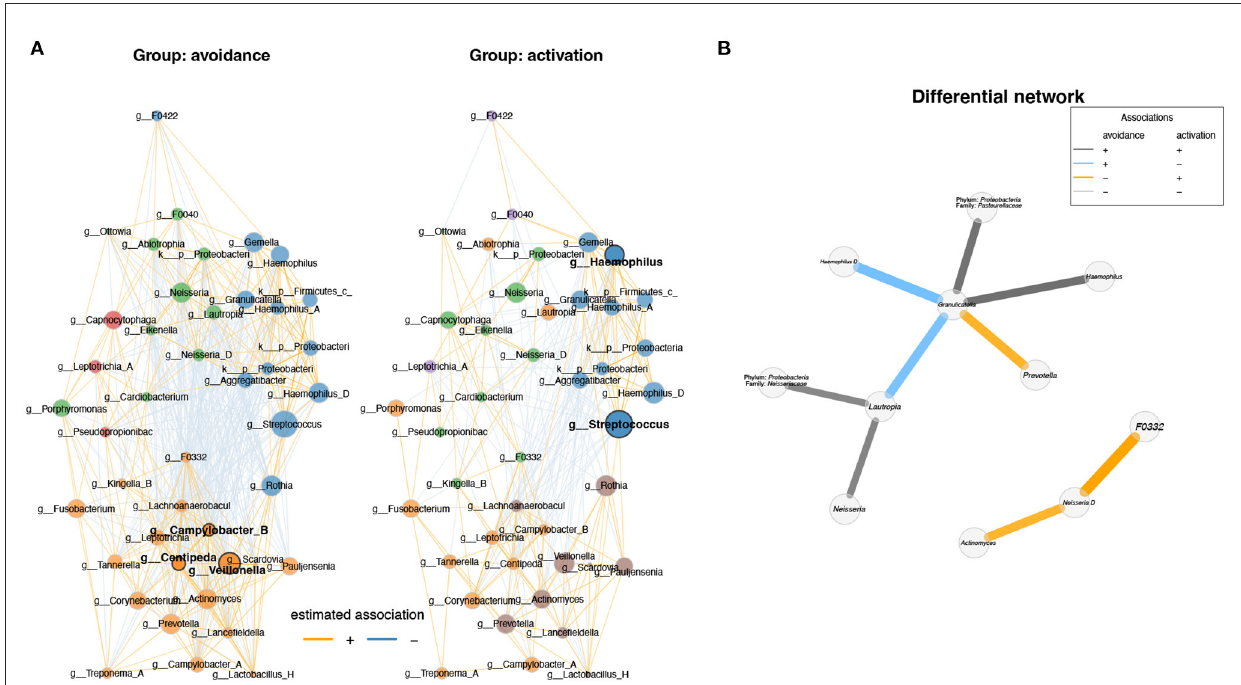
FIGURE3 Differential network analysis between BADS avoidance and activation groups shows different correlations between genera. (A) Network analysis of the top 50 genera showing the highest variation between the two conditions and visualized the results (degree, betweenness centrality, closeness centrality; p > 0.05). Network specific hub nodes are shown in bold font. (B) The differential network shows the different correlations between genera (Fisher exact test, p-adj < 0.1 BH adjusted); if genus annotation was not available, phylum and family are